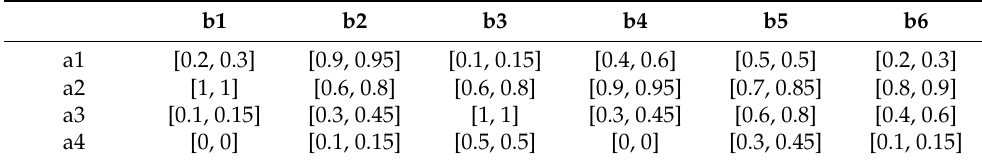
Table 4. Decision matrix expressed by vague values.